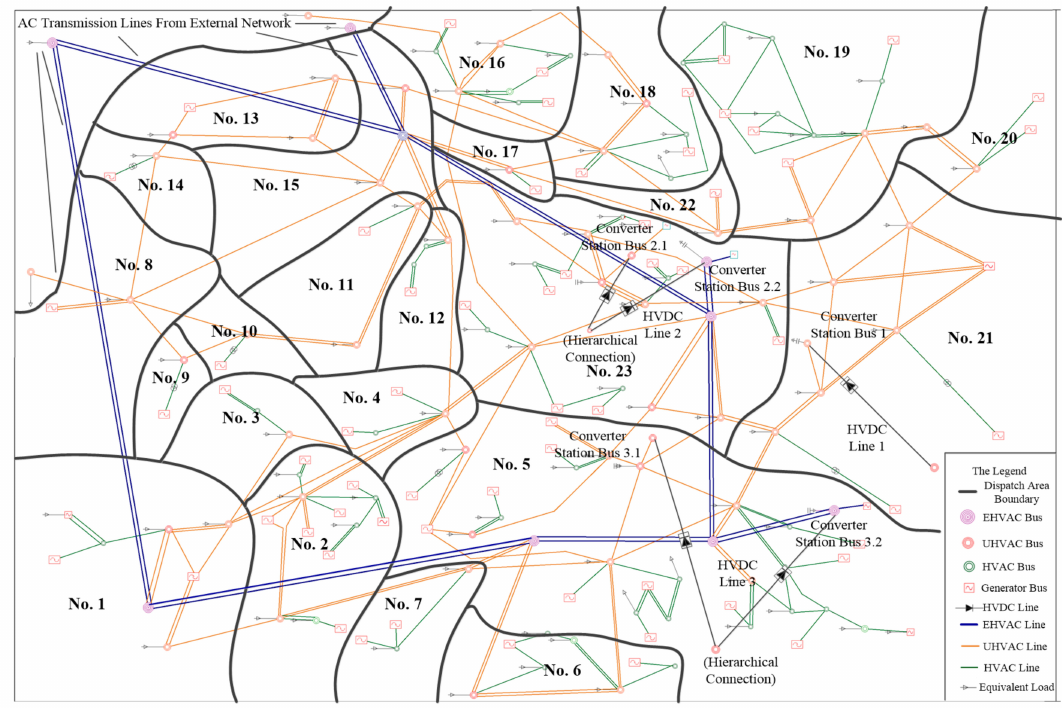
Figure 8. Dispatch areas of the test